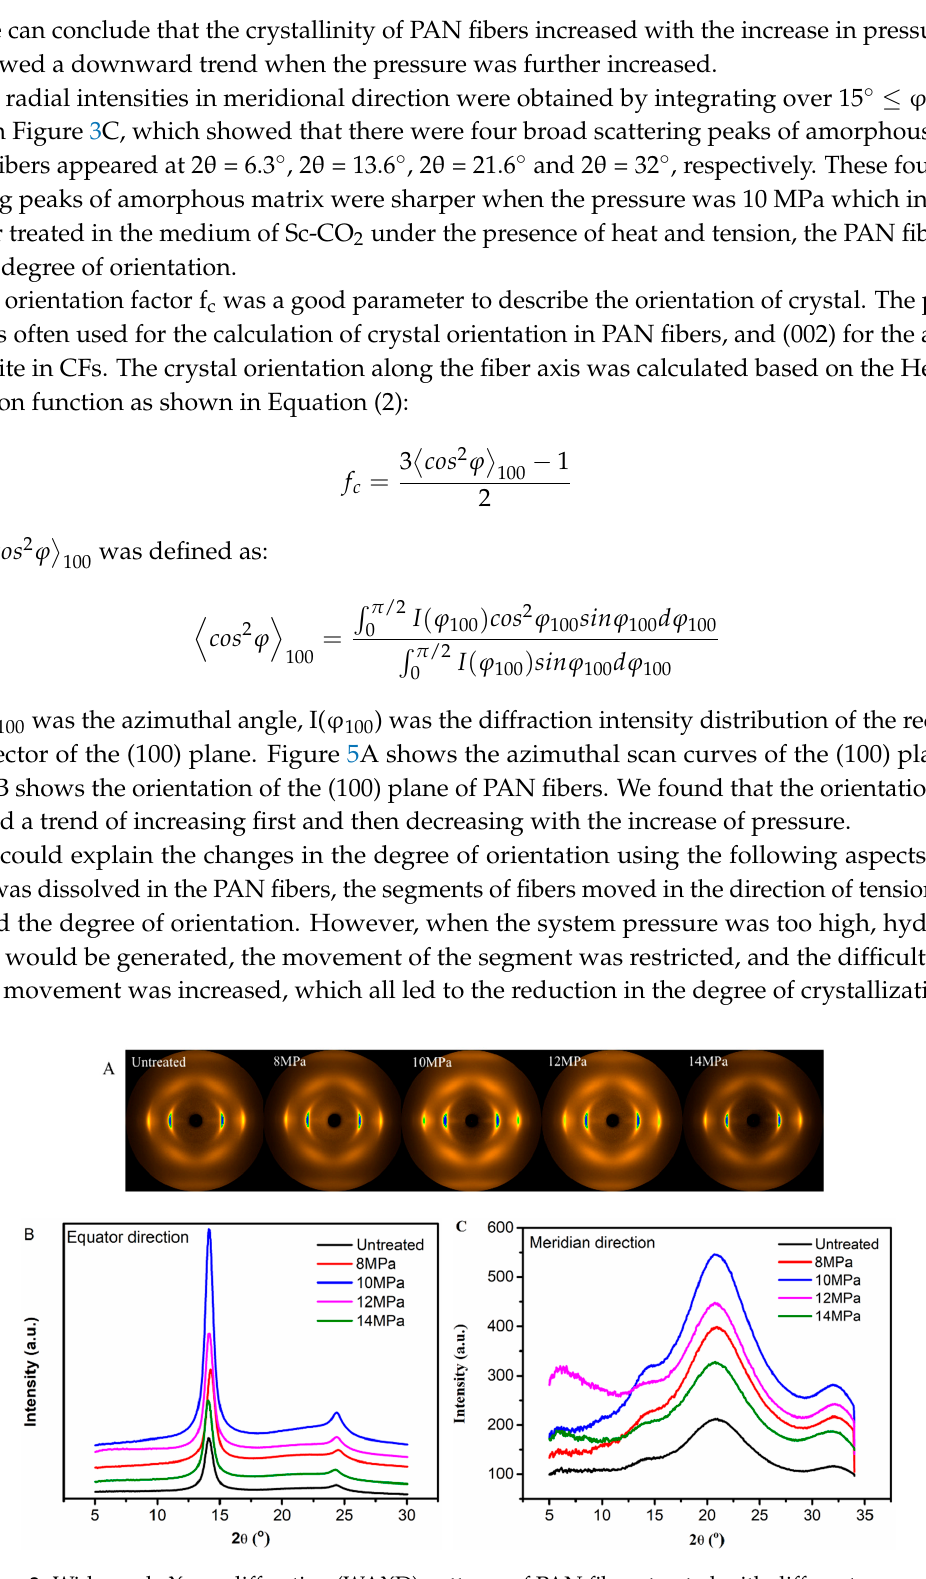
Figure 4. Crystallinity of PAN fibers treated at different pressures in Sc ‐ CO 2 .